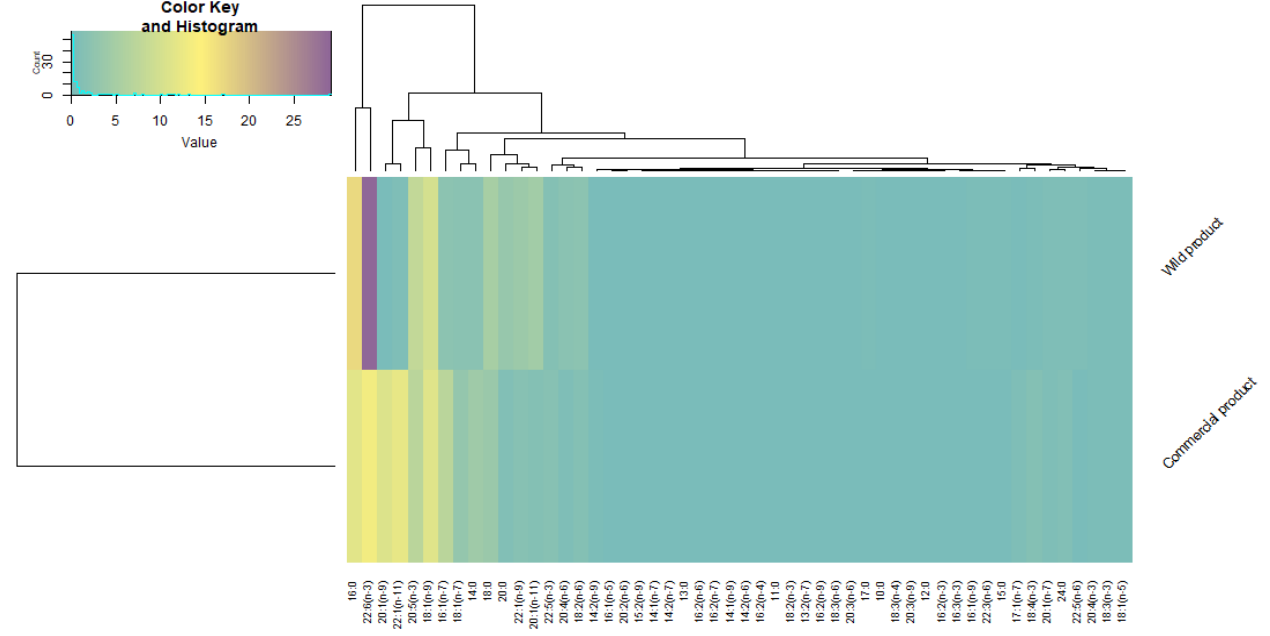
Figure 7. Heatmap of the qualitative and quantitative content of fatty acids (FA) in the muscle tis- sue from the wild and commercial beaked redfish Sebastes mentella . from the wild and commercial beaked redfish Sebastes mentella